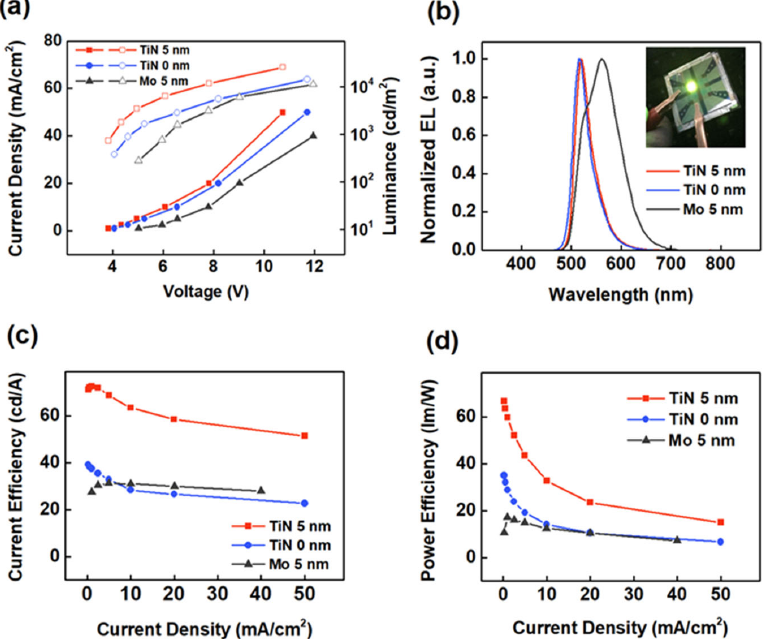
Figure 7. ( a ) Current density-voltage-luminance characteristics, ( b ) normalized EL spectra, ( c ) current efficiency versus current density characteristics, and ( d ) power efficiency versus current density characteristics of TE-OLEDs using Cr/Al/Cr, Cr/Al/Cr/TiN, and Cr/Al/Cr/Mo. The inset in ( b ) shows a typical photograph of the TE-OLED driven at 5 mA/cm 2 .